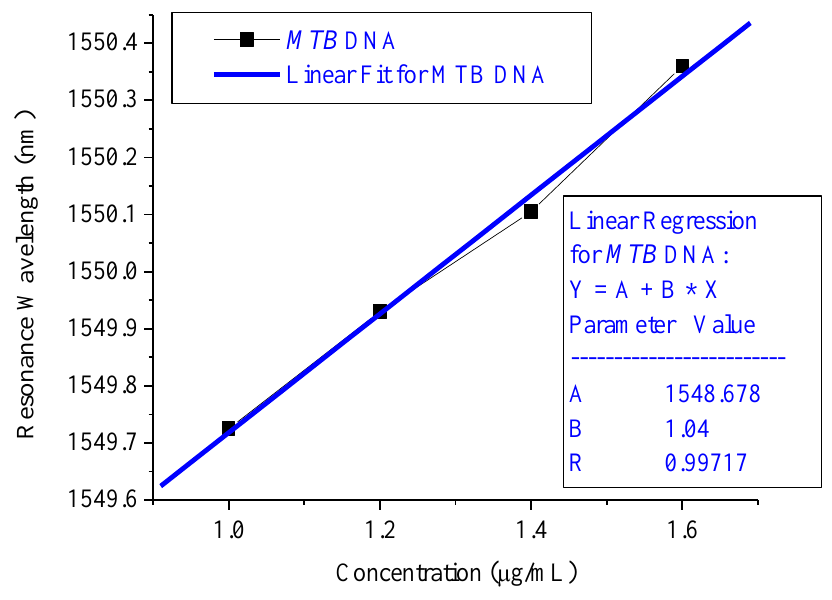
Figure 5. The MTB DNA sensor sensitivity under 5′-thiol end DNA probing